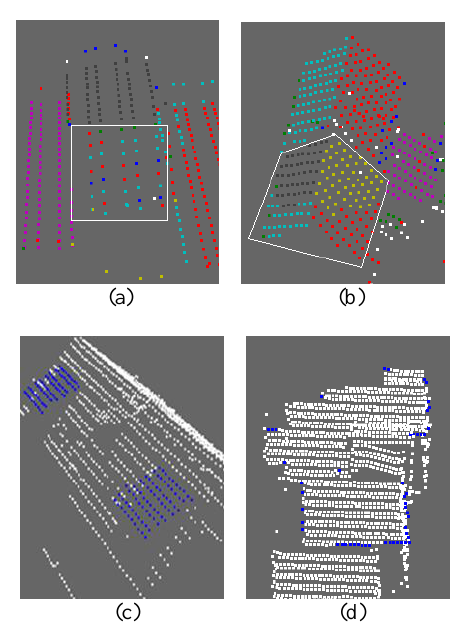
Figure 2: Planes detected by RANSAC. (a) Non-segmented planes (white square area). (b) Over-segmented planes (white polygonal area). (c) Under-segmented plane (blue points). (d) Spurious plane (blue points).